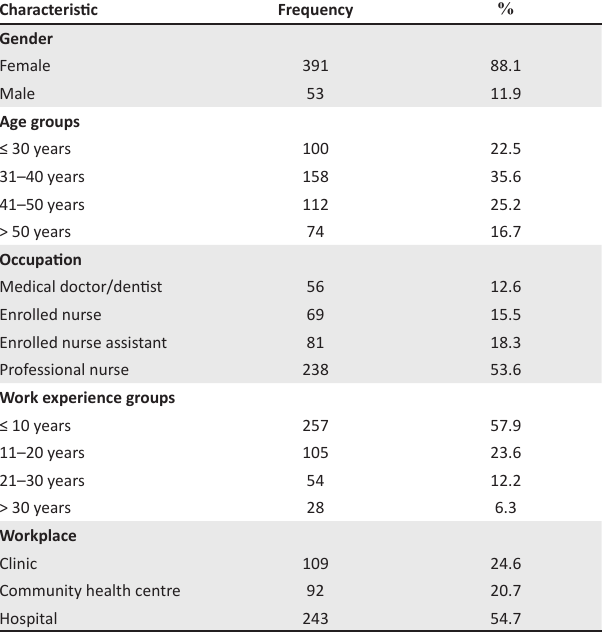
TABLE 1: Participants’ characteristics.